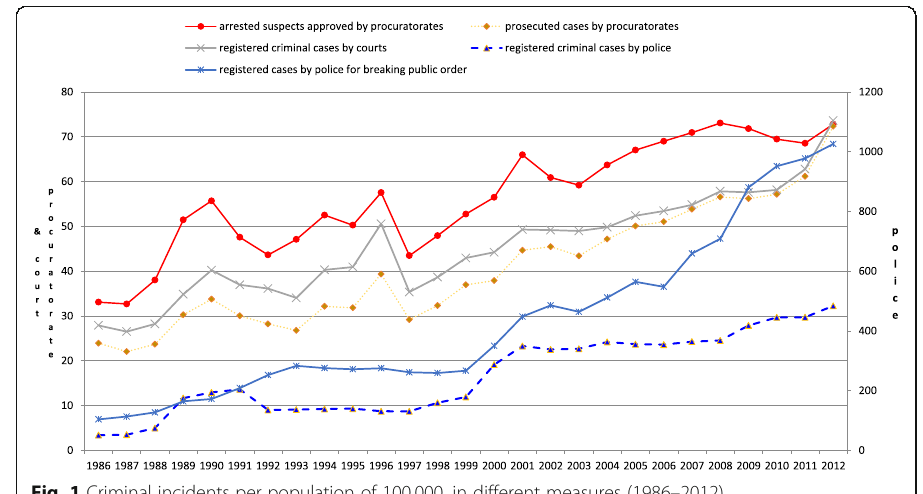
Fig. 1 Criminal incidents per population of 100,000, in different measures (1986 –